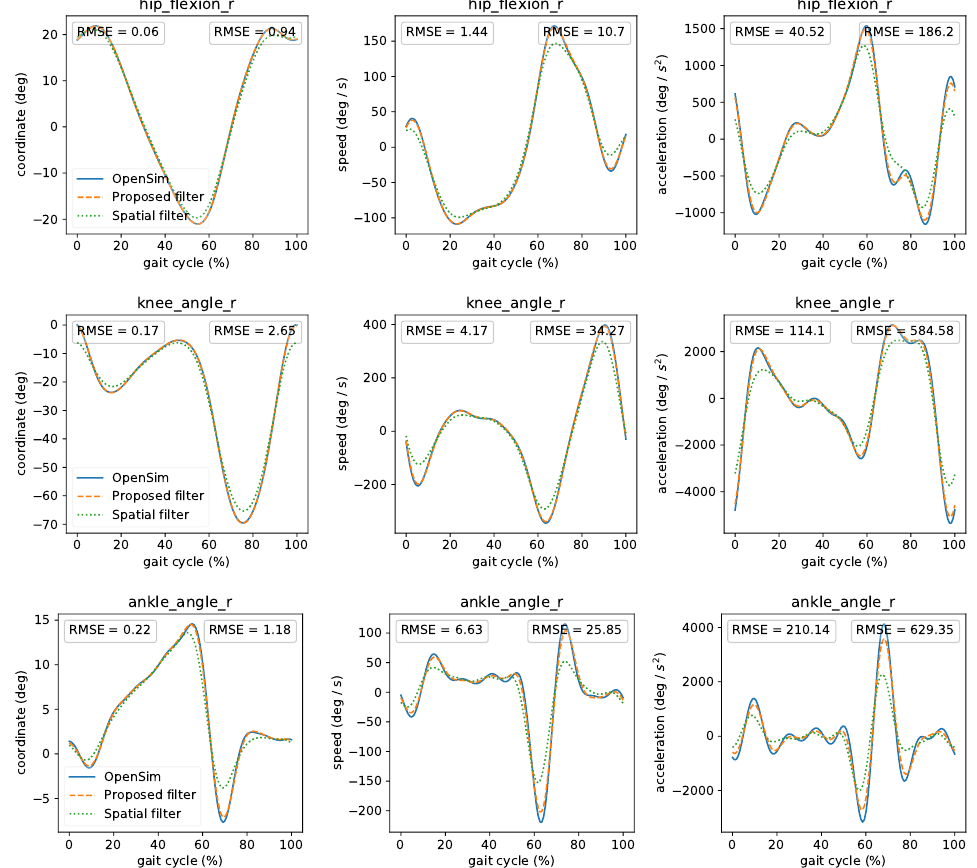
Figure 7. Comparison between OpenSim ’s offline kinematics analysis, the proposed, and spatial filters. Left RMSE compares OpenSim ’s and proposed filter’s kinematics. Right RMSE compares OpenSim ’s and spatial filter’s kinematics. For comparison reasons, we shifted the curves to compensate for the time lag introduced by the